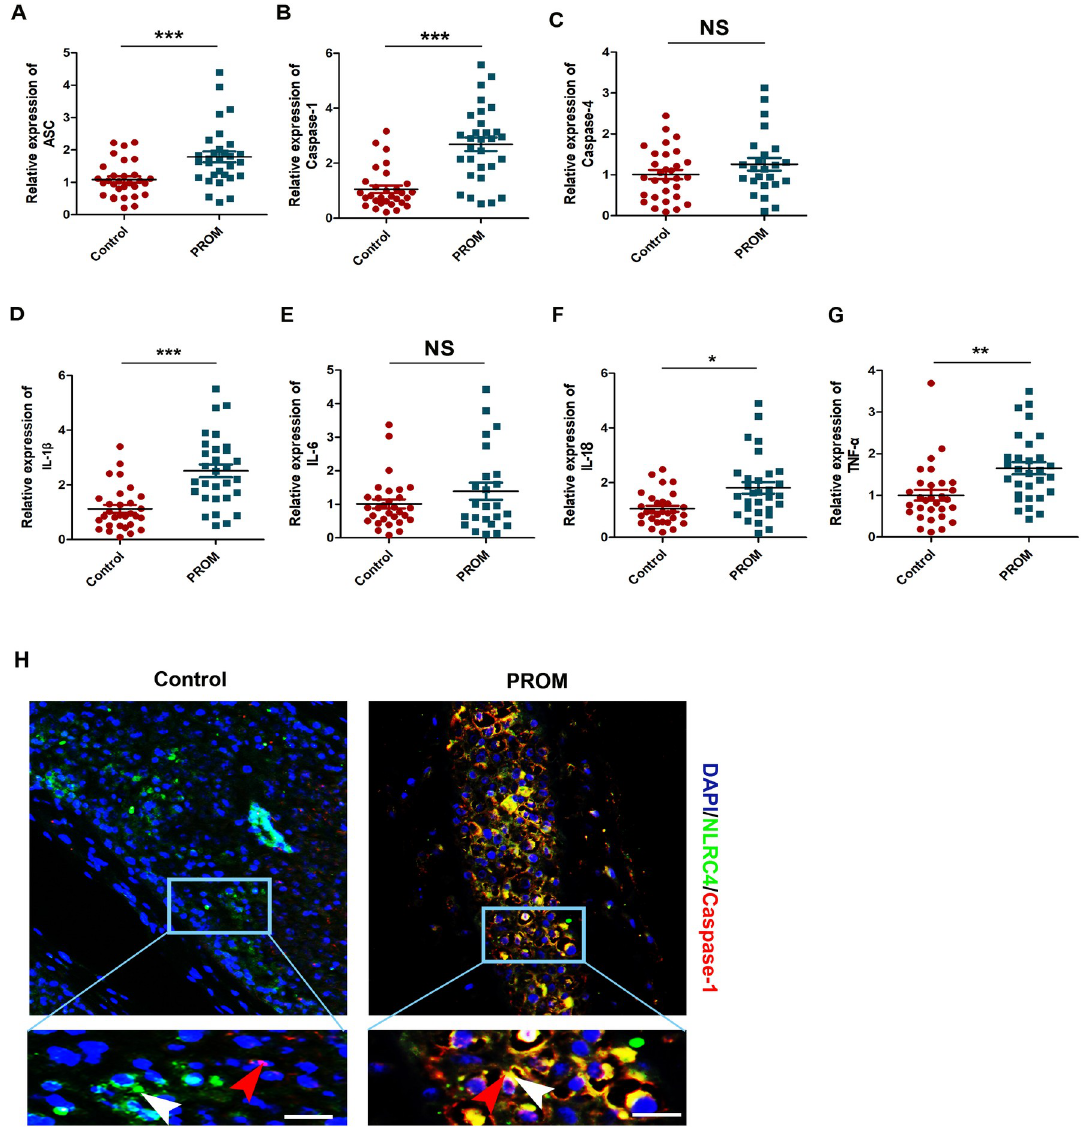
Fig 3. NLRC4 inflammasomes activation participates in TPROM process. (A-G) NLRC4 inflammasomes activation participates in PROM process. ASC, caspase-1, caspase-4, IL-1 β , IL-6, IL-18 and TNF- α gene expression in fetal membrane, � P < 0.05, �� P < 0.01, ��� P < 0.001, NS, P > 0.05 vs the control group, n = 30; (H) Immunofluorescence analysis of the expression of NLRC4 and caspase-1 in fetal membrane, bar = 20 μ m. maternal blood was significantly different in the patients with TPROM and non-TPROM pregnant (307.9 ± 27.8 versus 87.97 ± 14.3 [control], P < 0.01) (Fig 4A). It is worth noting that 6 women in the PROM group were diagnosed with TPROM com- bined with Histological chorioamnionitis (HCA). Considering that HCA is the main cause and common complication of PROM, we further analyzed the relationship between HCA and NLRC4 content in serum of patients with TPROM. As shown in Fig 4B and 4C, the NLRC4 level in both serum (460.2 ± 62.3 versus 289 ± 55.1 [control], P < 0.05) and fetal membranes (1.50 ± 0.16 versus 0.99 ± 0.08 [control], P < 0.01) of patients with TPROM combined with HCA was